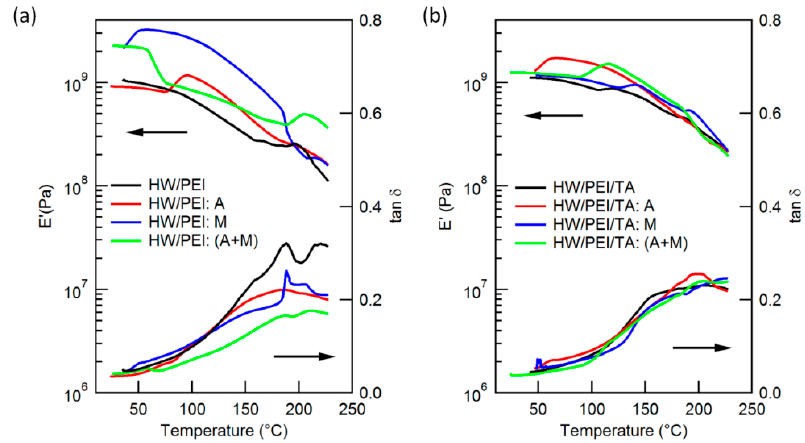
Figure 8. Dynamic mechanical analysis (DMA) results of ECAP consolidated ( a ) HW / PEI and ( b ) HW / PEI / TA.